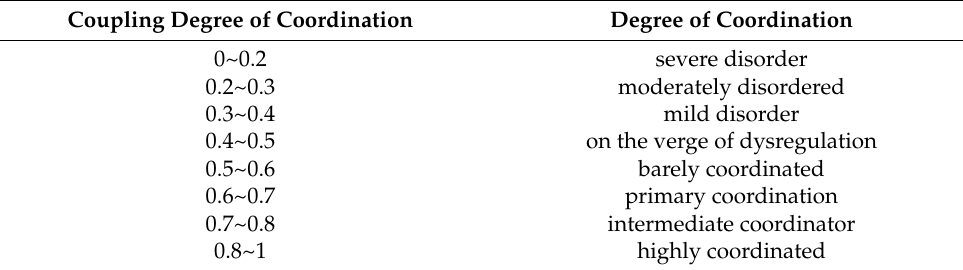
Table 3. Coupling coordination degree